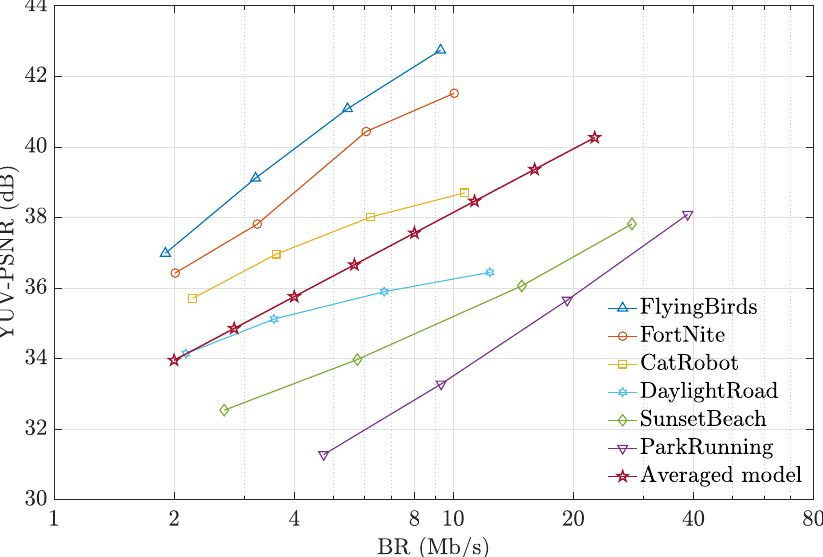
Figure 3. Versatile Video Coding (VVC): PSNR–BR data and linear RD models for 3840 × 2160 resolution sequences. The averaged RD model is also displayed as red line with star